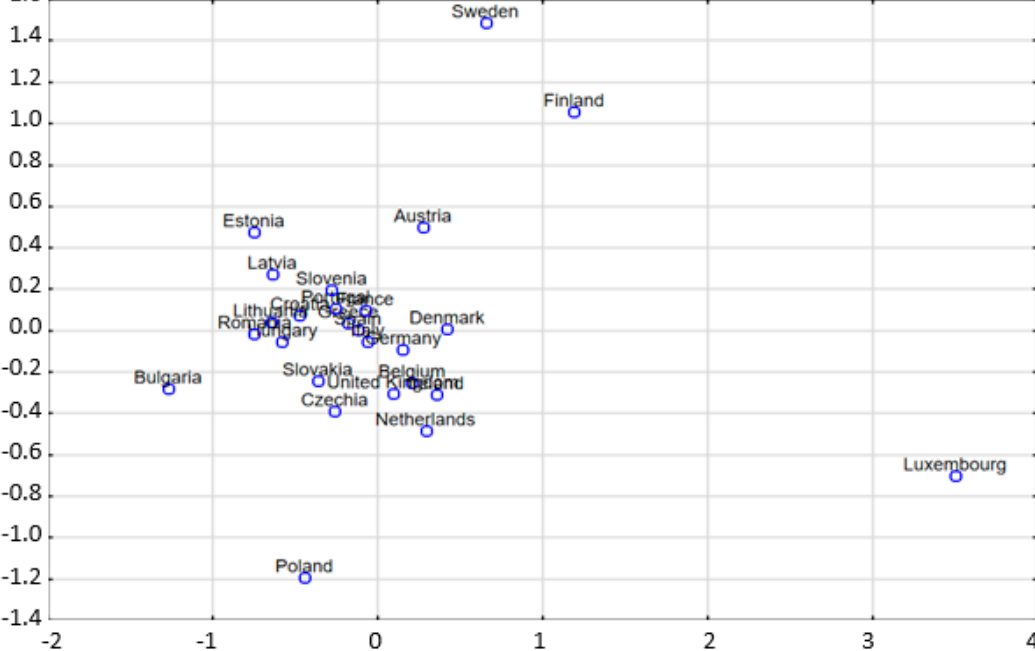
Figure 2. Sustainable development level of energy markets in two-dimensional graph for 2010.